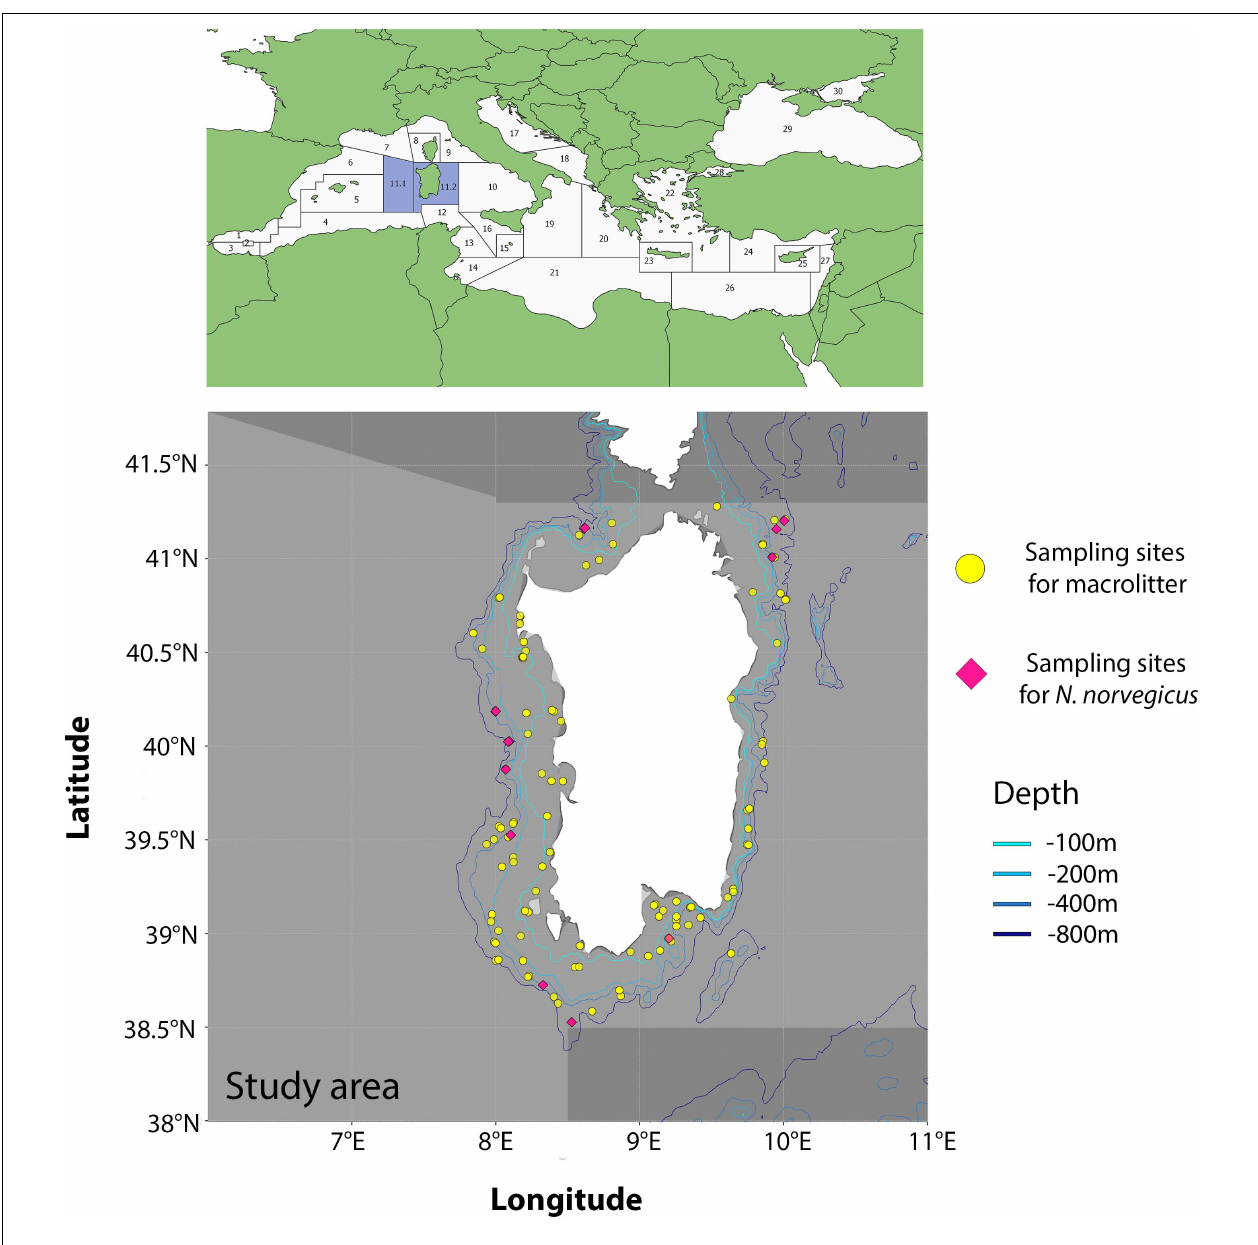
FIGURE 1 | Study area with the GSAs 11.1 and 11.2 evidenced (light gray). Purple diamonds refer to sites where samples of N. norvegicus were collected. Yellow points refer to MEDITS sampling sites where plastic items were